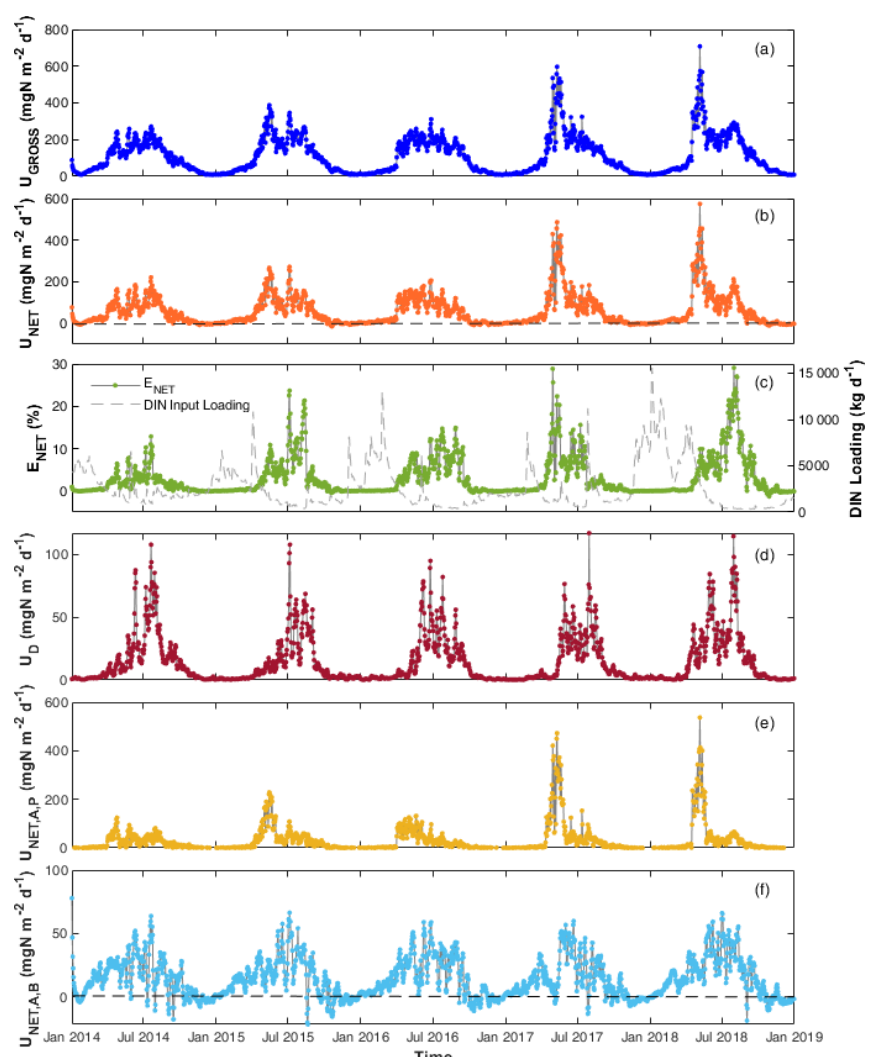
Figure 4. Daily DIN (a) gross uptake rate ( U GROSS ), (b) net uptake rate ( U NET ), (c) percentage net uptake ( E NET ), (d) denitrification rate ( U D ), (e) net uptake rate by phytoplankton ( U NET , A , P ), and (f) by benthic algae ( U NET , A , B ) in the Lower Bode river (2014–2018). Black dashed lines in panels (b) and (f) are zero lines to better show that the net N uptake is often negative in autumn and